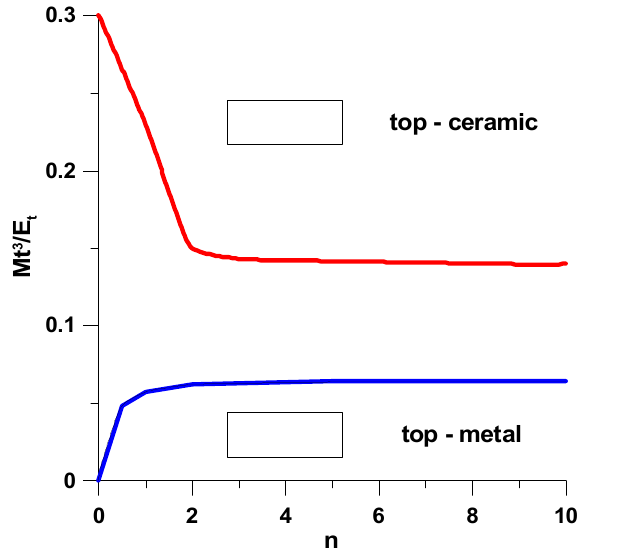
(cid:104) (cid:105) 2 D 11 − B with different location of unsymmetric 11 AB A 11 D with different location of unsymmetric ce-